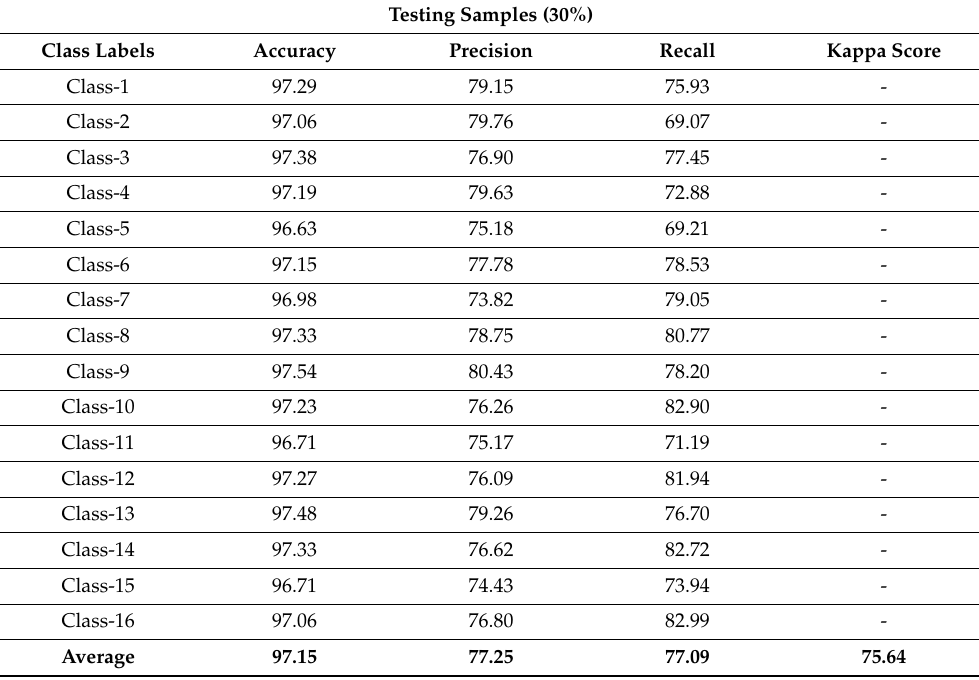
Table 6. Result analysis of the SSODTL-CC model with distinct classes under 30% of testing dataset-2.